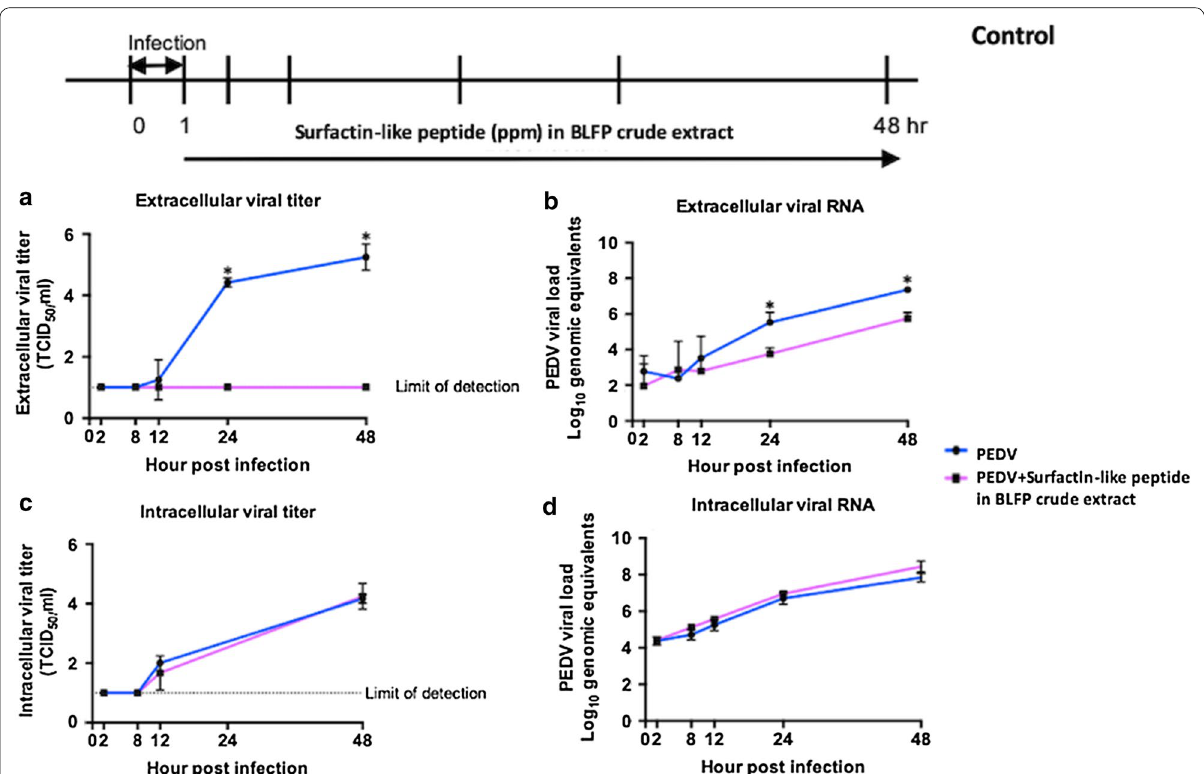
Fig. 8 Replication kinetics of PEDV in Vero cells treated with or without BLFP crude extract. a Extracellular viral titers in the supernatants of PEDV‑infected Vero cells treated with and without BLFP crude extract were determined by viral titration in Vero cells using the Reed‑Müench method and expressed as the 50% TCID 50 /ml. b Extracellular viral RNA levels in the supernatants of PEDV‑infected Vero cells treated with or without BLFP crude extract were determined by real‑time reverse transcription (RT)‑PCR. c Intracellular viral titers in PEDV‑infected Vero cells treated with or without BLFP crude extract were determined by viral titration in Vero cells. d Intracellular viral RNA levels in the supernatants of PEDV‑infected Vero cells treated with or without BLFP crude extract were determined by real‑time RT‑PCR. Statistical analysis was performed using Student’s t‑test, and statistically significant differences were labeled with *( p <